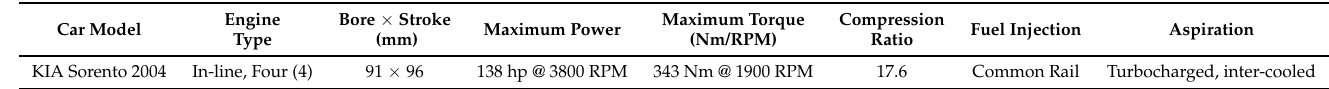
Table 1. Test engine specifications.